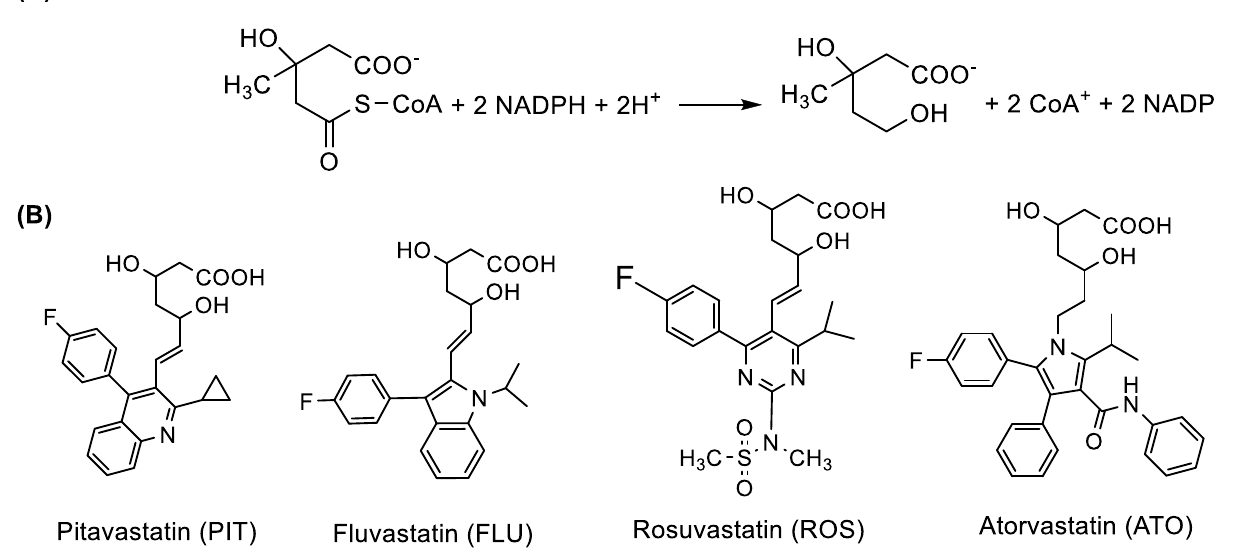
Figure 1. The HMG-CoA reductase reaction ( A ) and the chemical structures of the investigated HMG-CoA reductase inhibitors (statins) with their abbreviations ( B ).